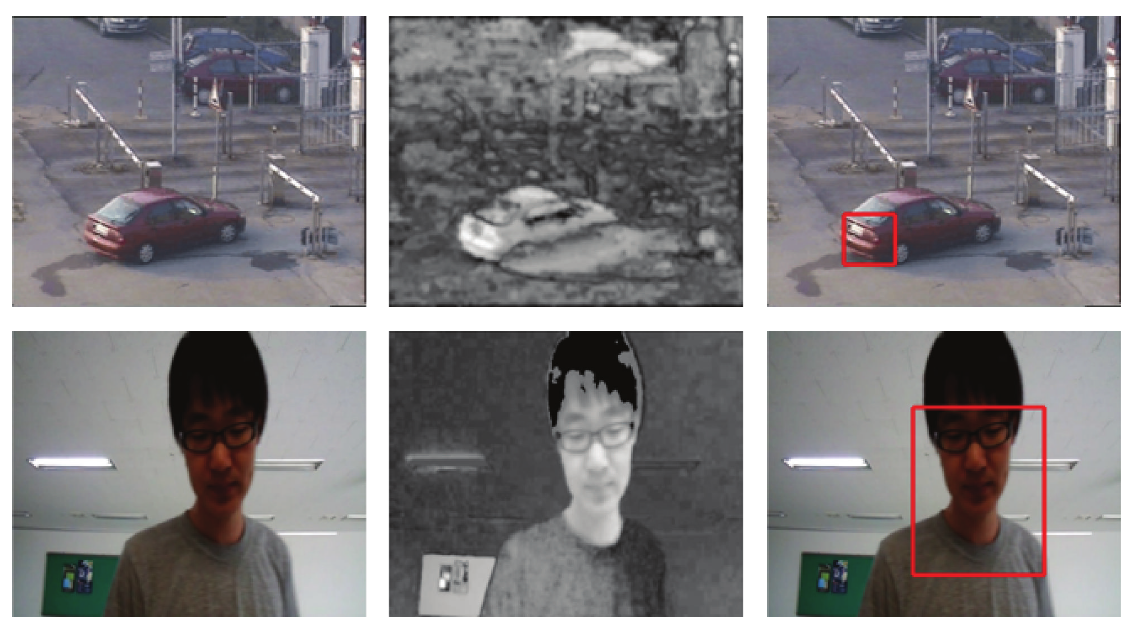
Figure 9: Videos (3) and (4): results using colour saliency